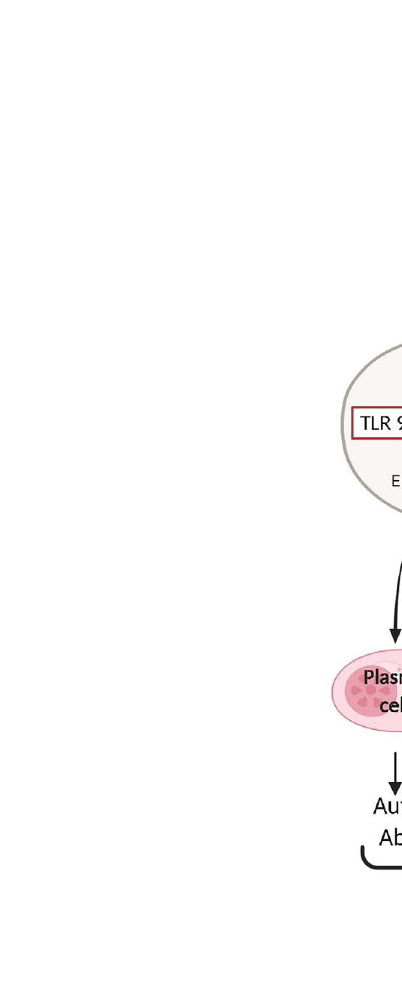
FIGURE 2 | DNASE1L3 de fi ciency leads to systemic lupus erythematosus (SLE). DNASE1L3 de fi ciency leads to the accumulation of numerous forms of DNA including chromatin, MP associated DNA and NET-associated DNA. Accumulation of such DNA contributes to the aberrant activation of TLR7,9 in B cells and plasmacytoid dendritic cells (pDCs). In B cells TLR7,9 activation leads to their differentiation into plasma cells and antibody forming cells (AFC) that produce autoreactive antibodies mostly directed against dsDNA. In pDCs TLR7,9 activation induces the production of type I interferons (IFN-I) which also play an important role in the transition of B cells into AFC. The production of anti-dsDNA antibodies and of IFN-I will ultimately cause the development of Systemic Lupus Erythematosus